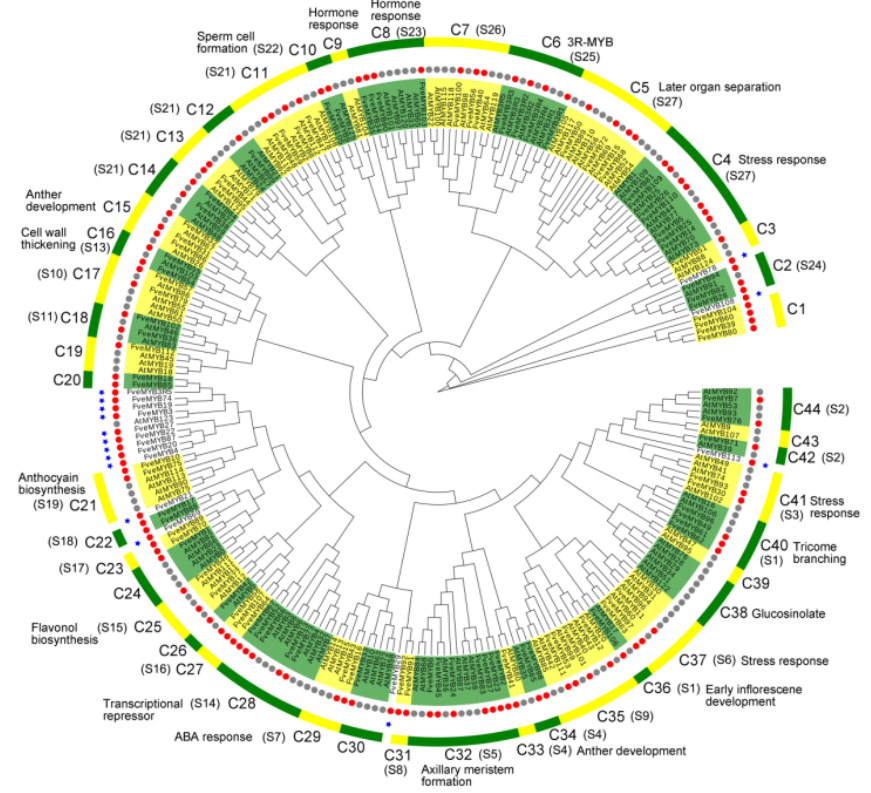
Figure 3. The phylogenetic tree of 2R-MYB and 3R-MYB proteins from woodland strawberry and Arabidopsis . According to previous study in soybean [26], the phylogenetic tree was divided into 44 phylogenetic clades (C1 – C44) based on bootstrap values (>50). Red dots represent MYB proteins from woodland strawberry. Grey dots represent MYB proteins from Arabidopsis . Blue stars represent MYB proteins from woodland strawberry not fit into any clades (bootstrap support values <50). S1 – S29 are group numbers of strawberry 2R-MYB and 3R-MYB proteins named in Figure 1. The function of some members from Arabidopsis was annotated outside the circle.